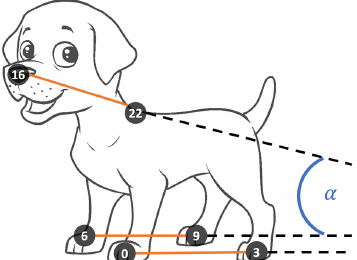
Figure 5. Calculation of the head